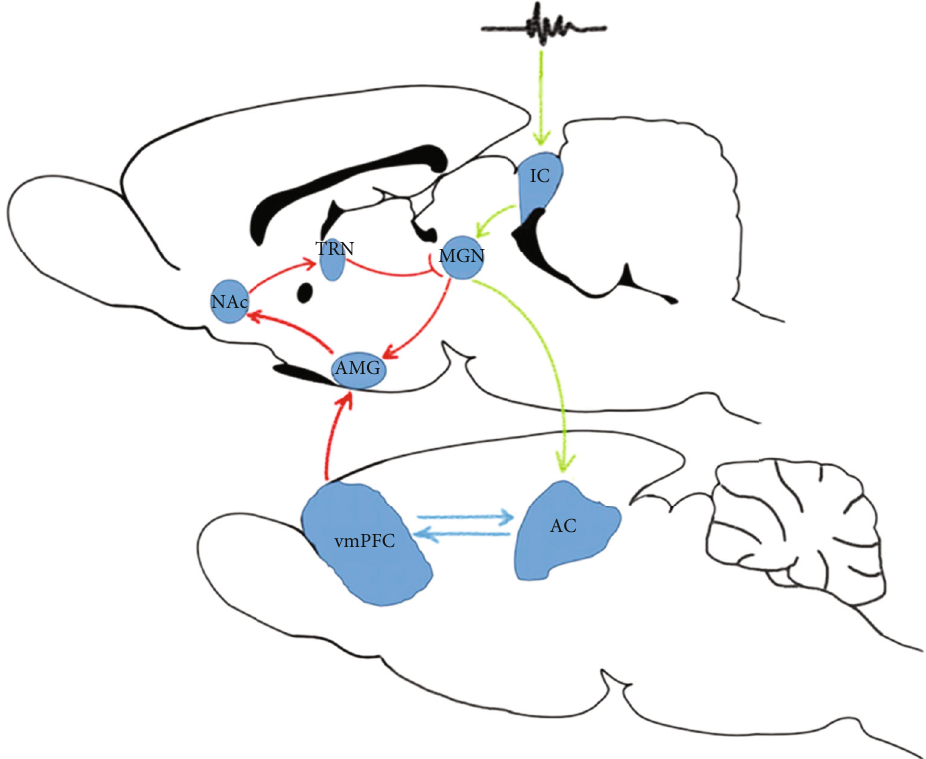
Figure 4: A schematic drawing of the neuronal structures and their projections of the auditory pathway (green lines) and limbic system (red lines) which might be involved in tinnitus and hyperacusis. Please note that the drawing primarily shows the structures and connections most relevant in the context of the proposed mechanism but are not exhaustive. Abbreviations: AC: auditory cortex; vmPFC: ventromedial prefrontal cortex; NAc: nucleus accumbens; AMG: amygdala; IC: inferior colliculi; MGN: medial geniculate nucleus, TRN: thalamic reticular